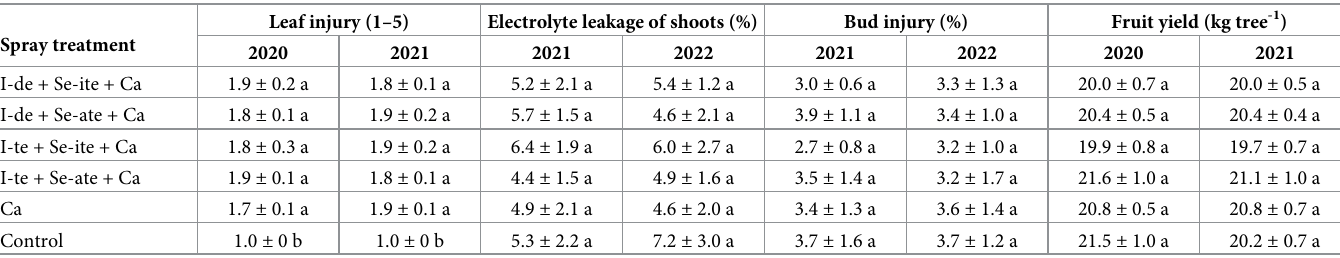
Table 3. Effects of combined sprays of iodine (I), selenium (Se) and calcium (Ca) on phytotoxicity, cold injuries and yield of ‘Red Jonaprince’ apple trees. Spray